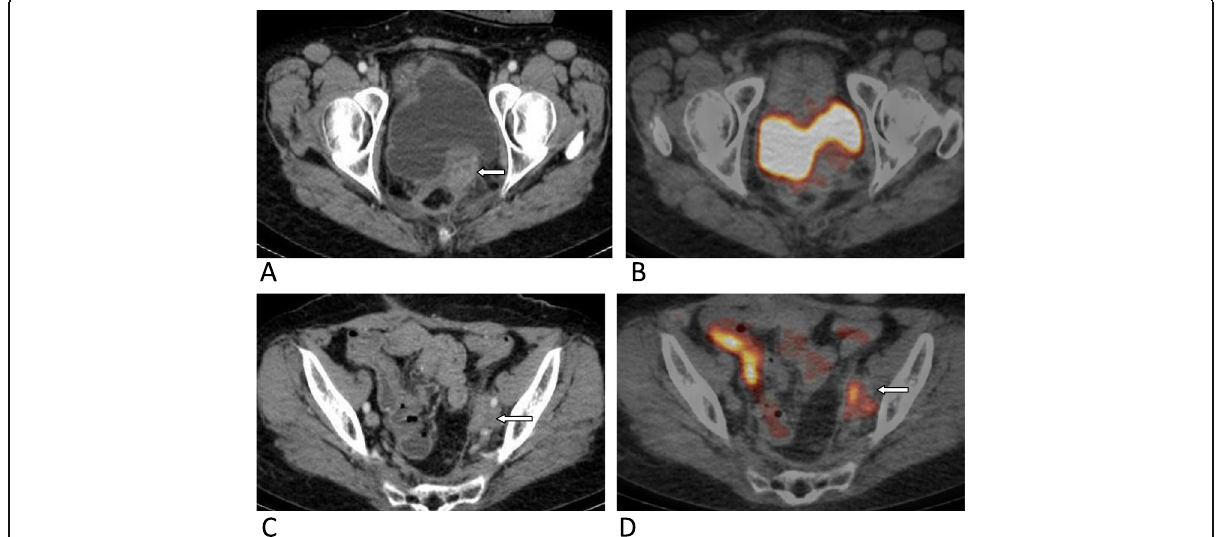
Fig. 5 A 57-year-old female patient who underwent rectal resection for pathologically proven adenocarcinoma, followed by chemotherapy, presented 4 months later by left loin pain and elevated tumor markers. a Axial post-contrast CT image showing operative bed faintly enhancing mass (arrow) encasing the distal left ureter (arrow). b Axial fused PET – CT image showing no metabolically active lesions noted in the operative bed. c Axial post-contrast CT image showing left iliac enlarged LNs (arrow). d Axial fused PET – CT image showing left iliac metabolically